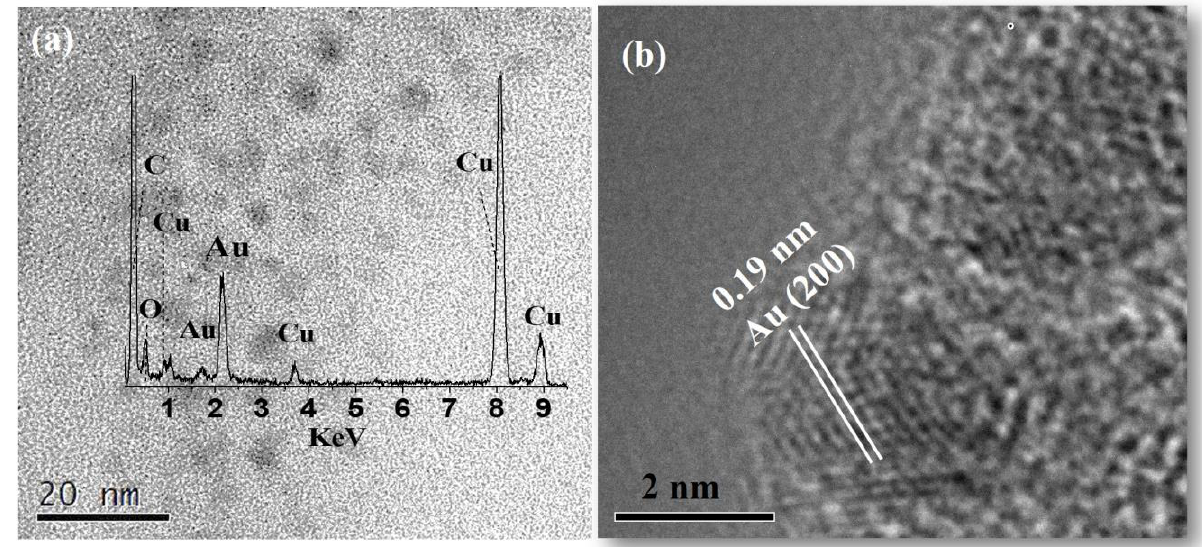
Figure 4. ( a ) HRTEM image of different AuNCs after bleaching, together with EDX measurement. ( b ) HRTEM of a single AuNC after separation. The interplanar distance of 0.19 nm is highlighted, typical of the (200) plane of face-centered cubic (fcc) metallic gold [39].